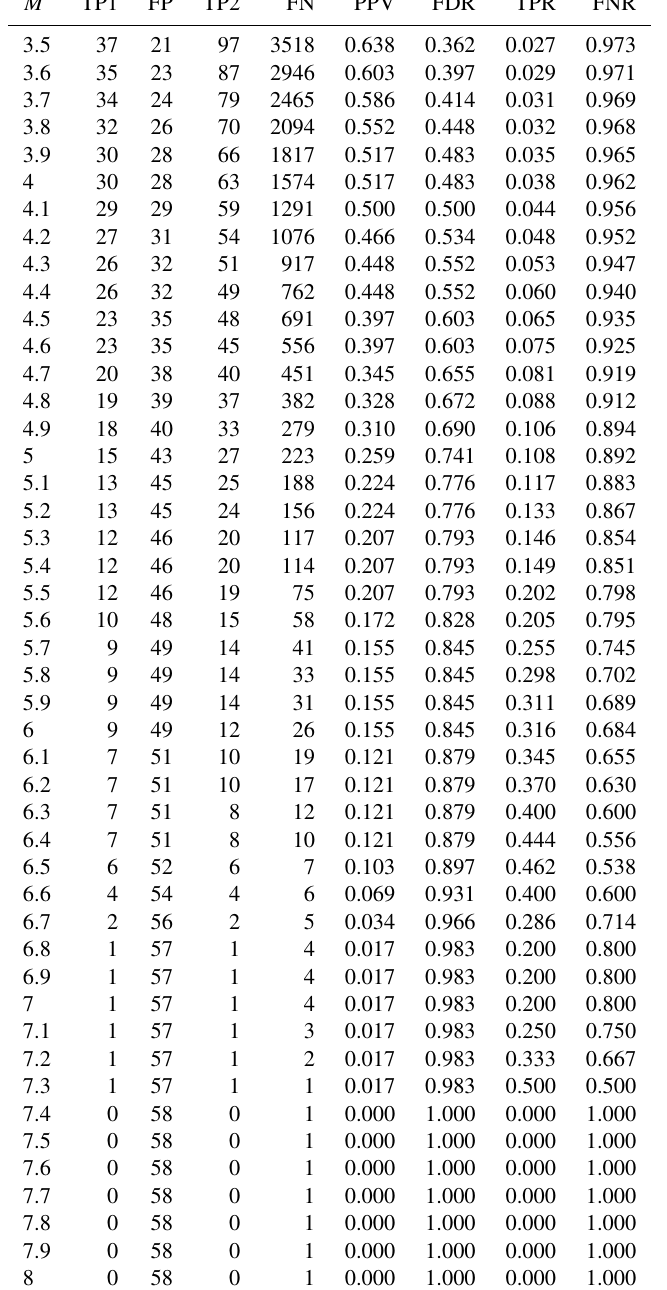
Table 3. Detailed results of earthquakes including period C (from April to July